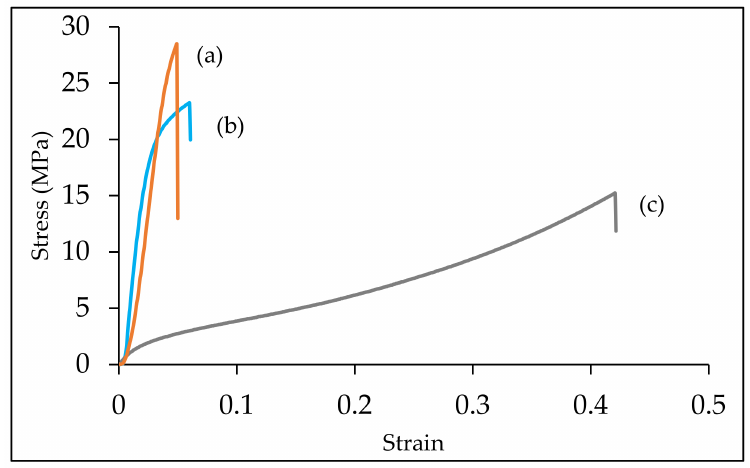
Figure 7. Stress–strain curves of pristine pectin ( a ), bilayer ( b ) and pristine chitosan films ( c ). Deposition of pectin onto chitosan improved the tensile strength by 2-fold while the Young modulus was improved by 5-fold. In short, bilayer films presented the average values of the mechanical characteristics of both polymers. Similar improvements were also observed by Baron et al. in 50:50 chitosan and pectin blend films [54]. While the elongation at break (EAB) of bilayer film did not show any intermediate values, it was very close